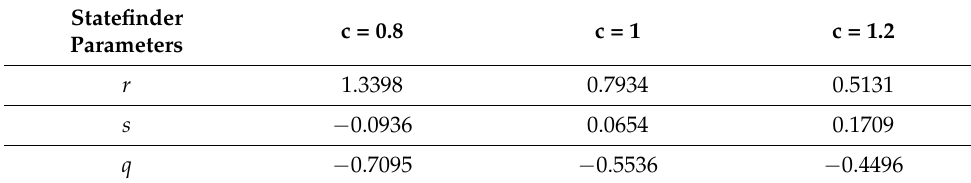
Figure 7. The parameter r ( q ) as a function of the deceleration parameter q . The arrows denote the evolution directions of r ( q ) and the dark line shows the time evolution of the Λ CDM model. The stars on the curves indicate current states of the model for different values of c , and the point of ( − 1,1 ) corresponds to the steady state model (SS)—the de Sitter expansion. Table 1. Values of statefinder paramters at z = 0 for the three cases of the parameter c